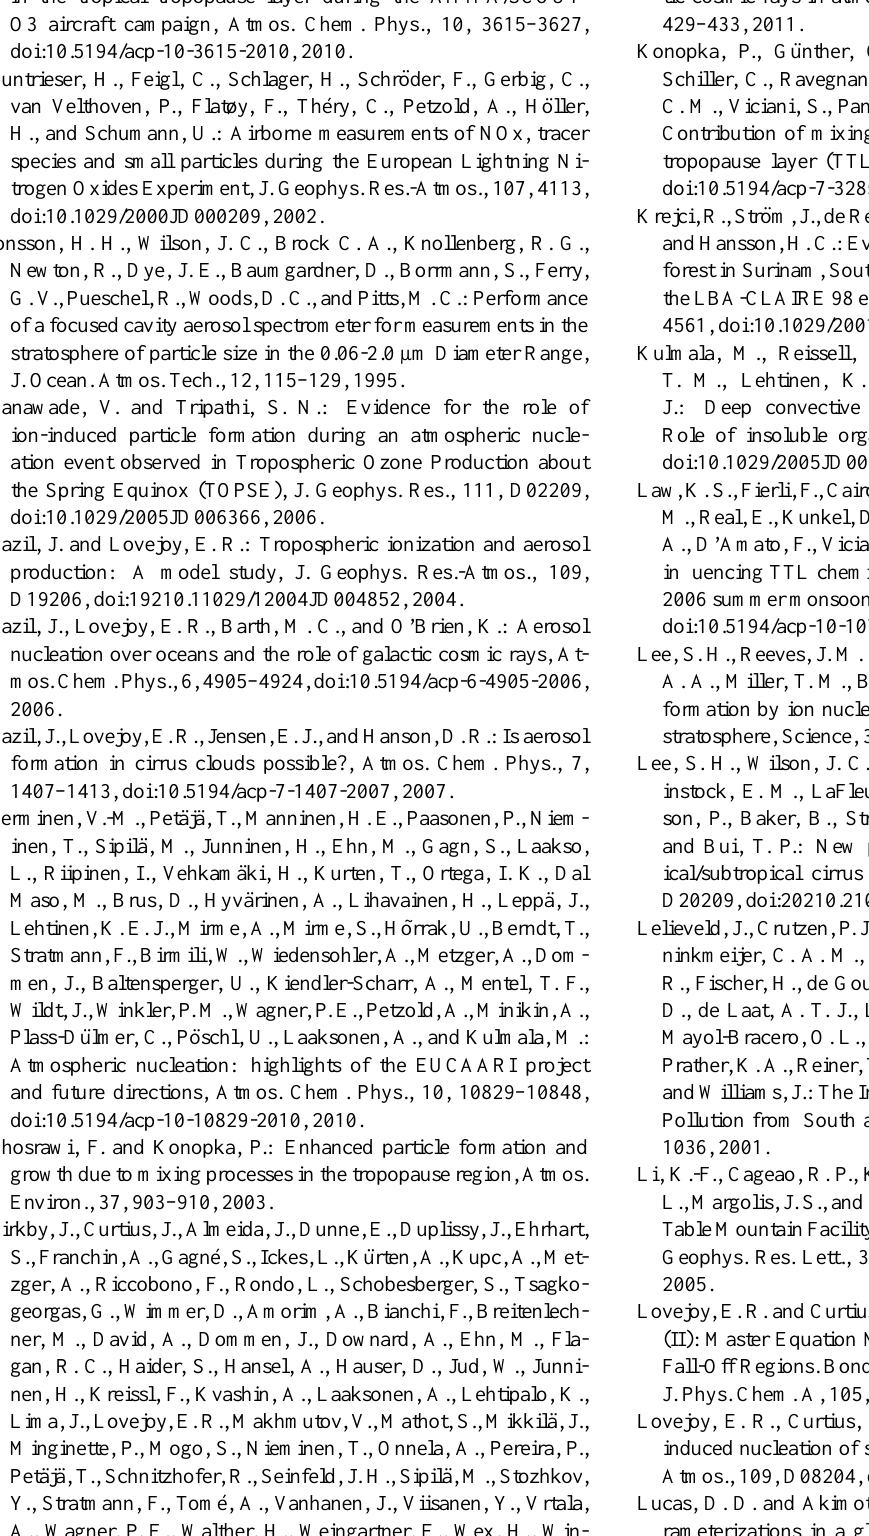
Table Mountain Facility, California: AM-PM diurnal